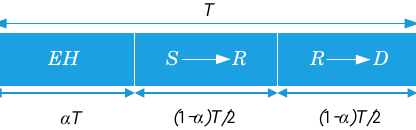
Figure 3. The time switching-based relaying (TSR)